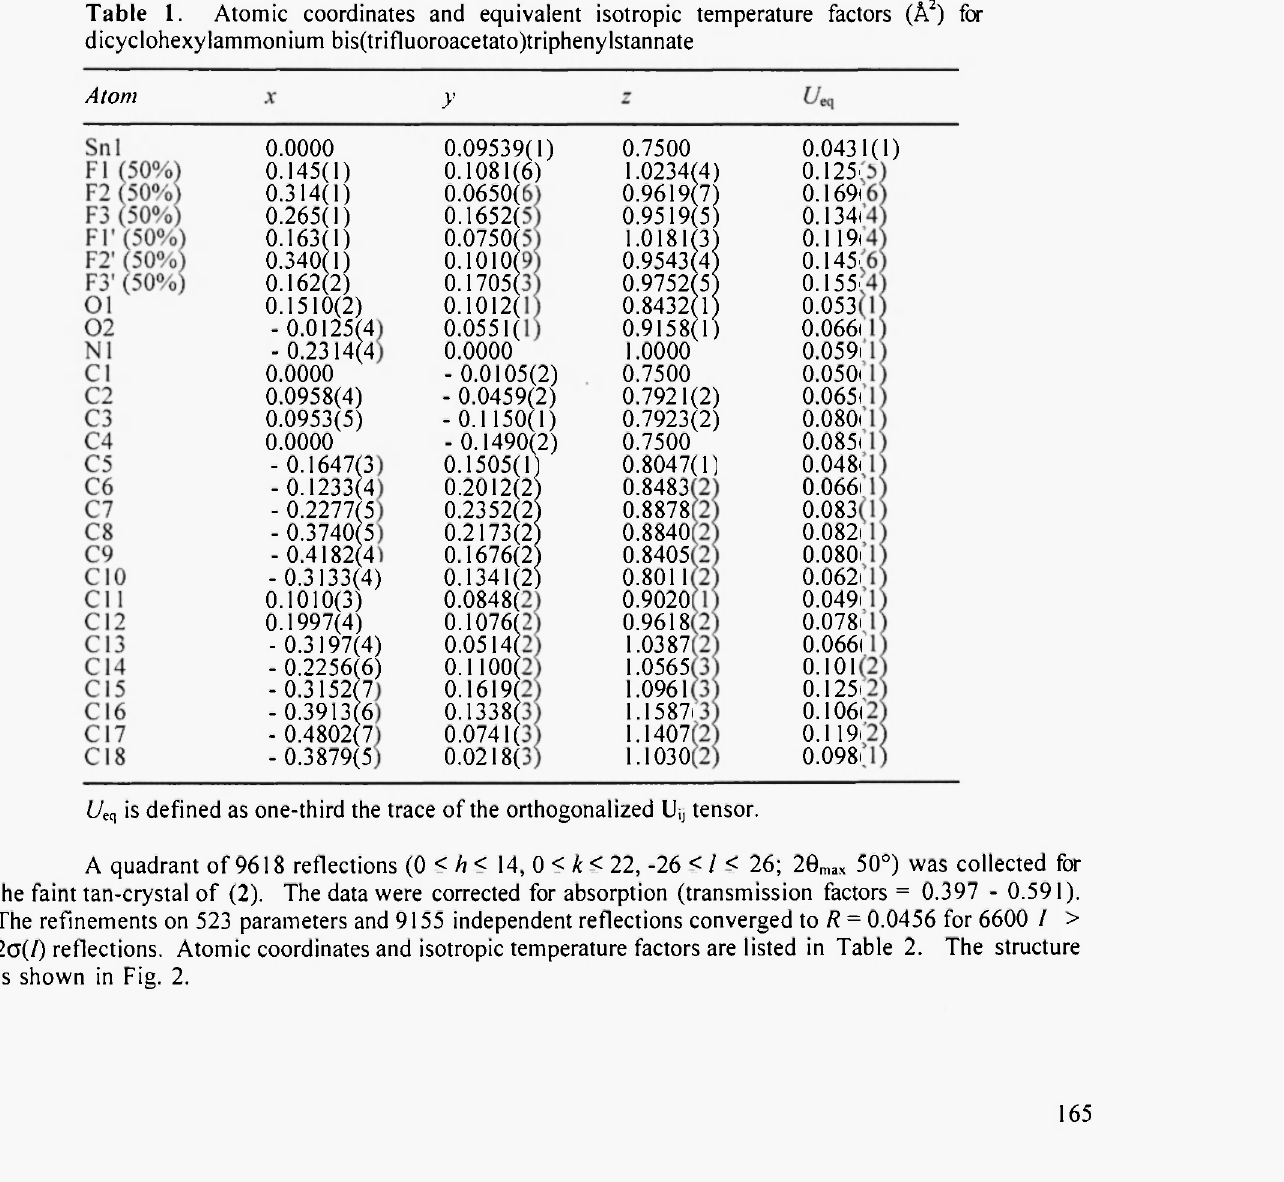
Atomic coordinates and equivalent isotropic temperature factors (A 2 )